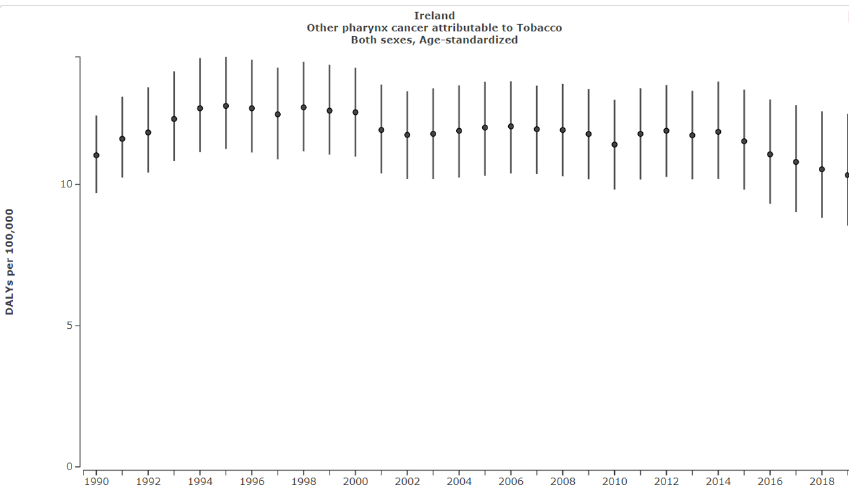
Figure 6. Other pharyngeal cancer in Ireland attributable to tobacco. Source: Institute for Health Metrics Evaluation. Used with permission. All rights reserved [1].